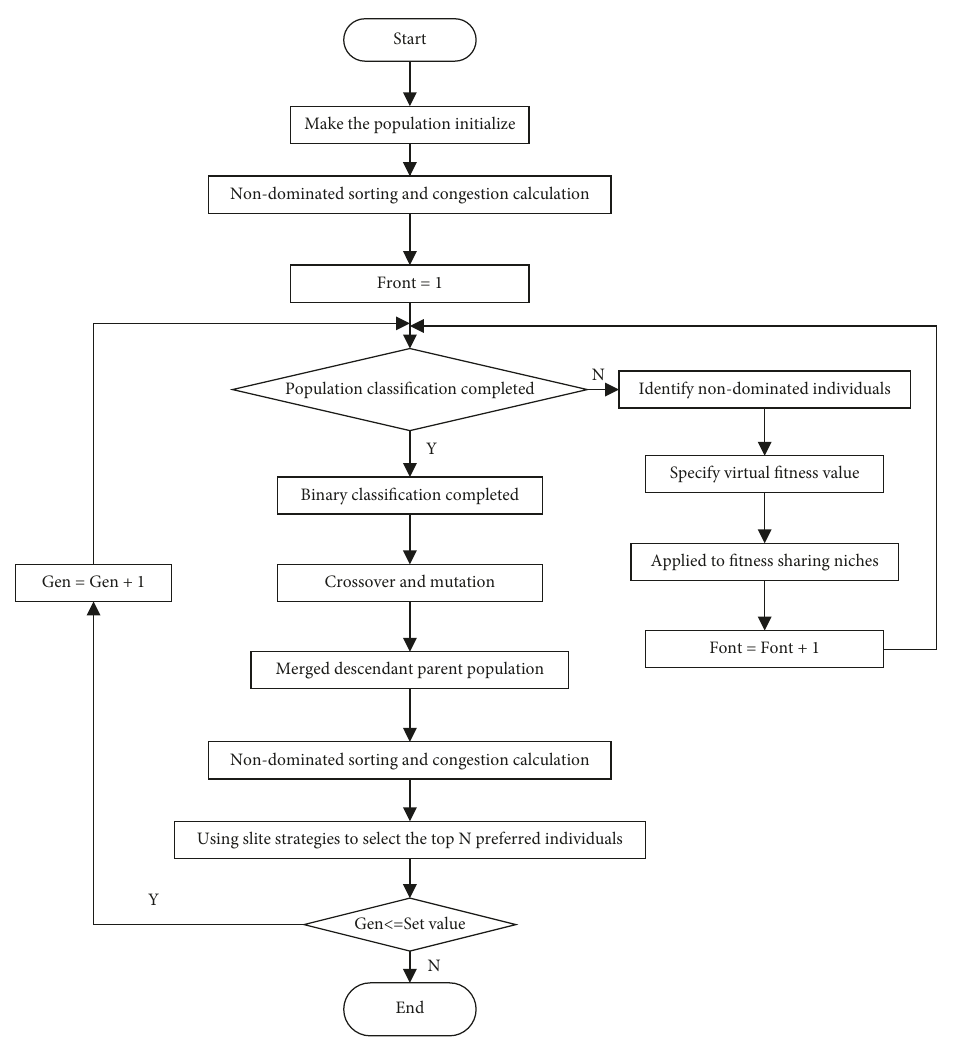
Figure 4: NSGA-II algorithm flow